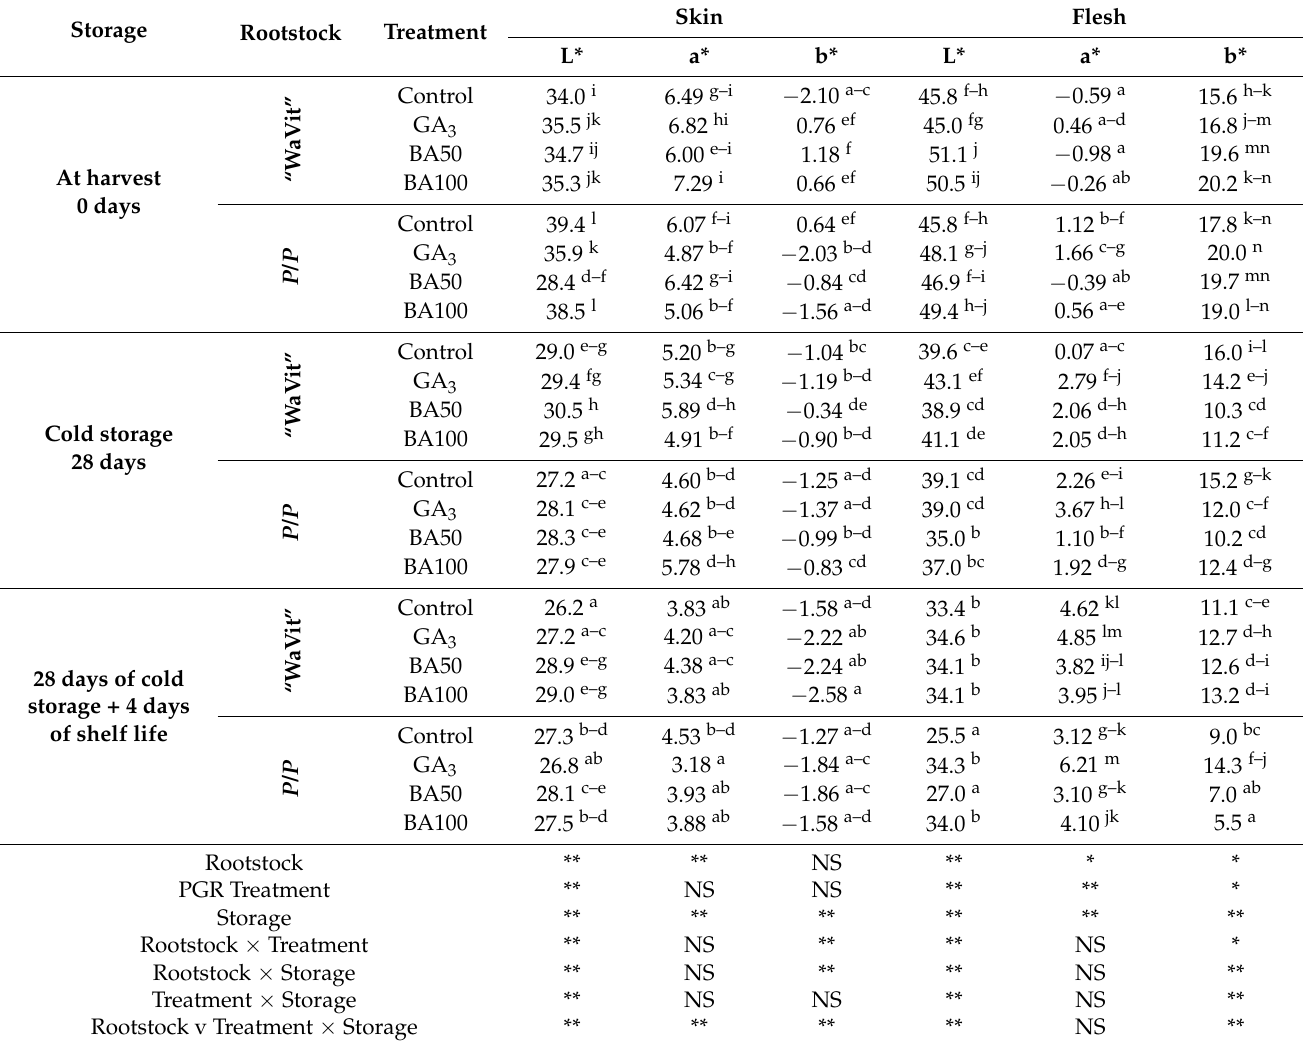
Table 2. Changes in color properties of skin and flesh of fresh and stored plums grown on two different rootstocks (“WaVit” and P. cerasifera / P. spinosa ) influenced by PGR